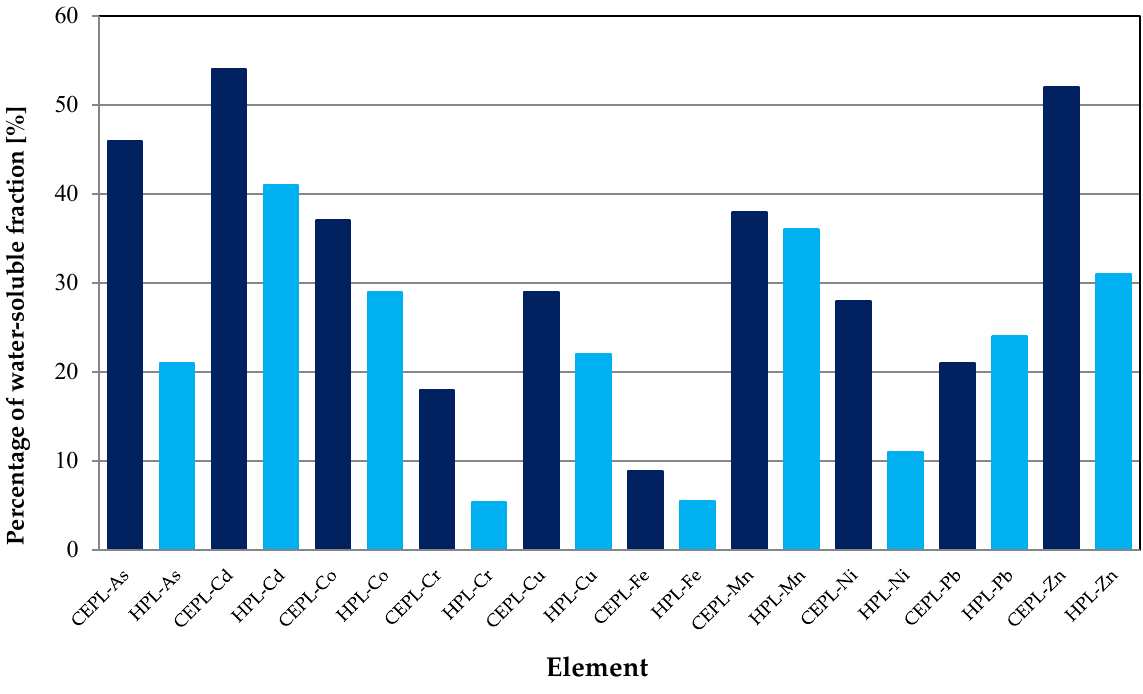
Figure 5. Mean proportion of water-soluble fractions of PTEs in the urban air classified as follows: CEPL—commonly encountered pollution level; HPL—high pollution level.